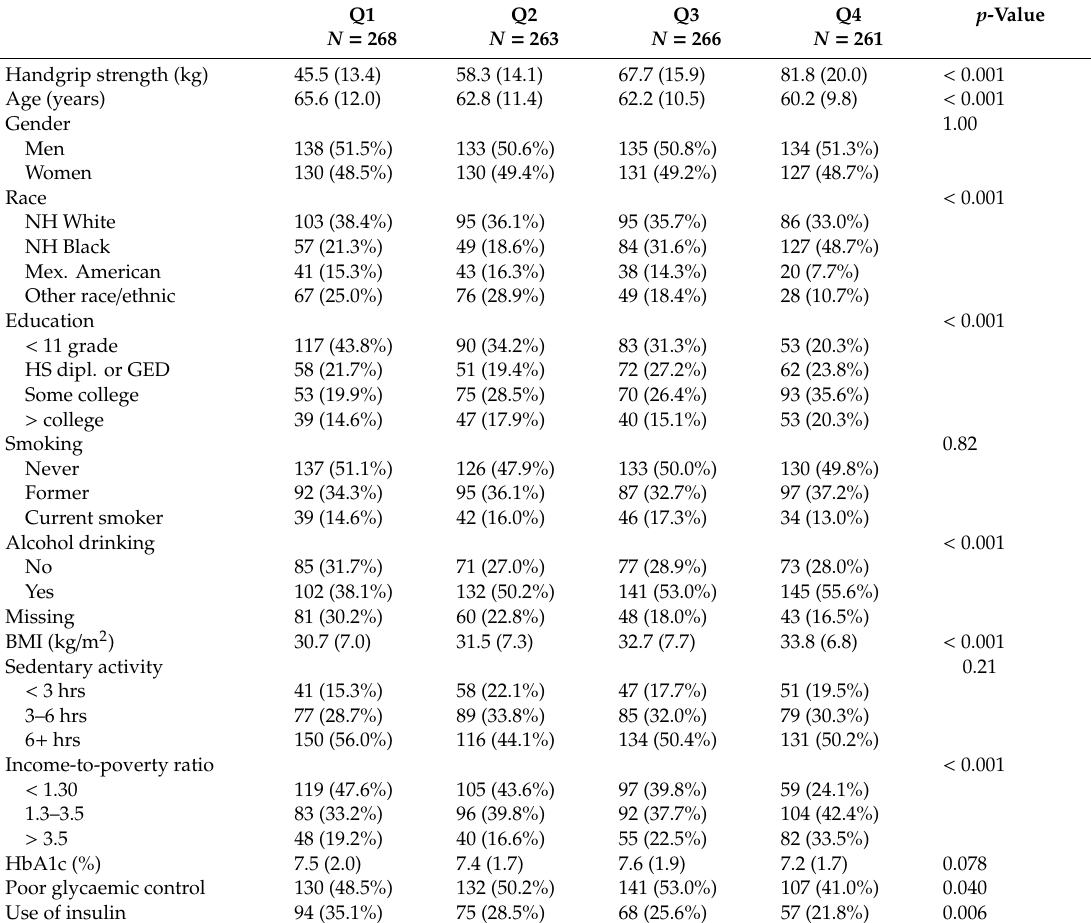
Table 1. Sample characteristics by quartiles of handgrip strength ( N =